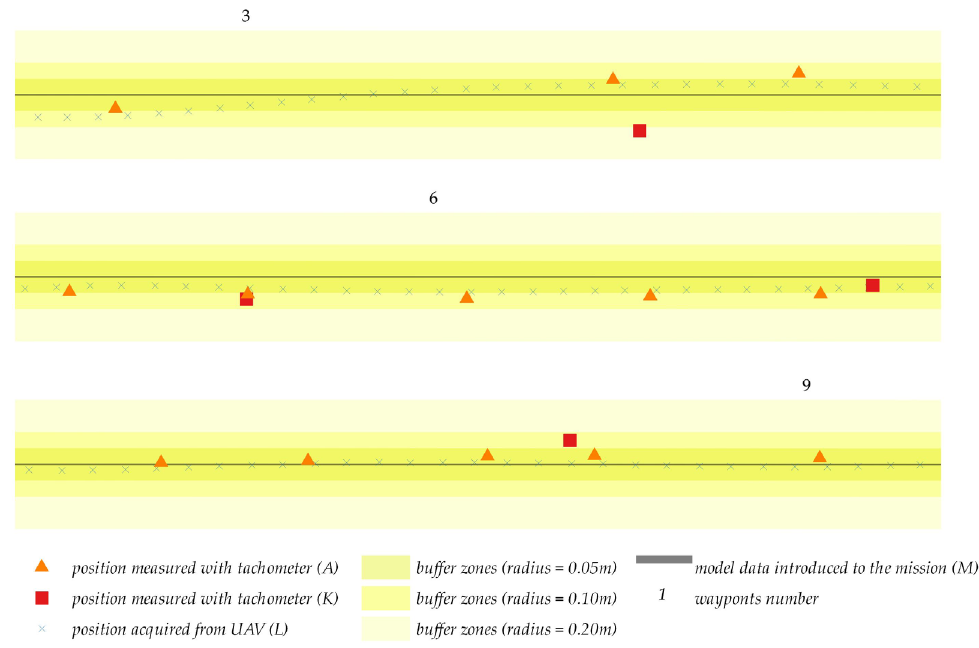
F igure 14. Measured values presented for selected segment of the flight